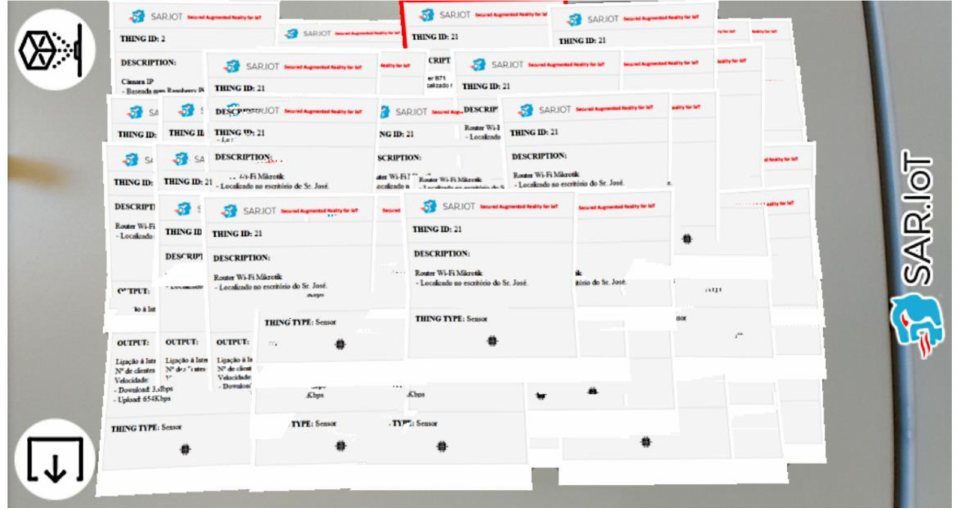
Figure 26. Performance test with multiple AR